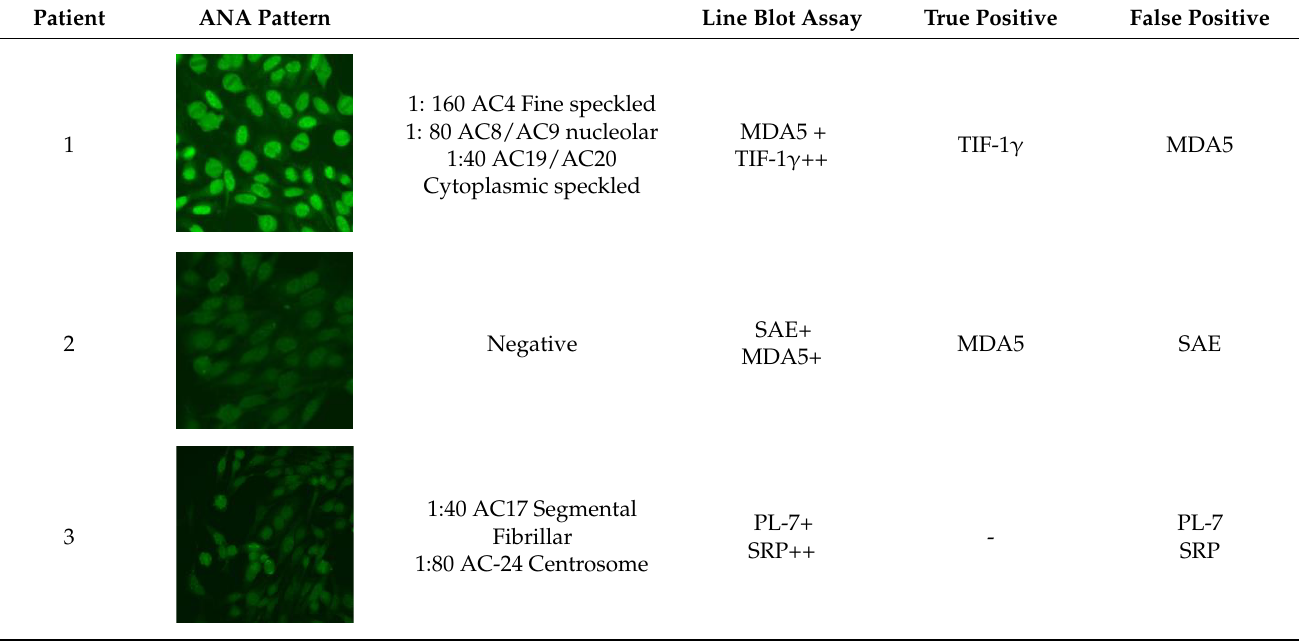
Table 2. Summary of ANA pattern of 23 patients with double seropositivity in line blot test.